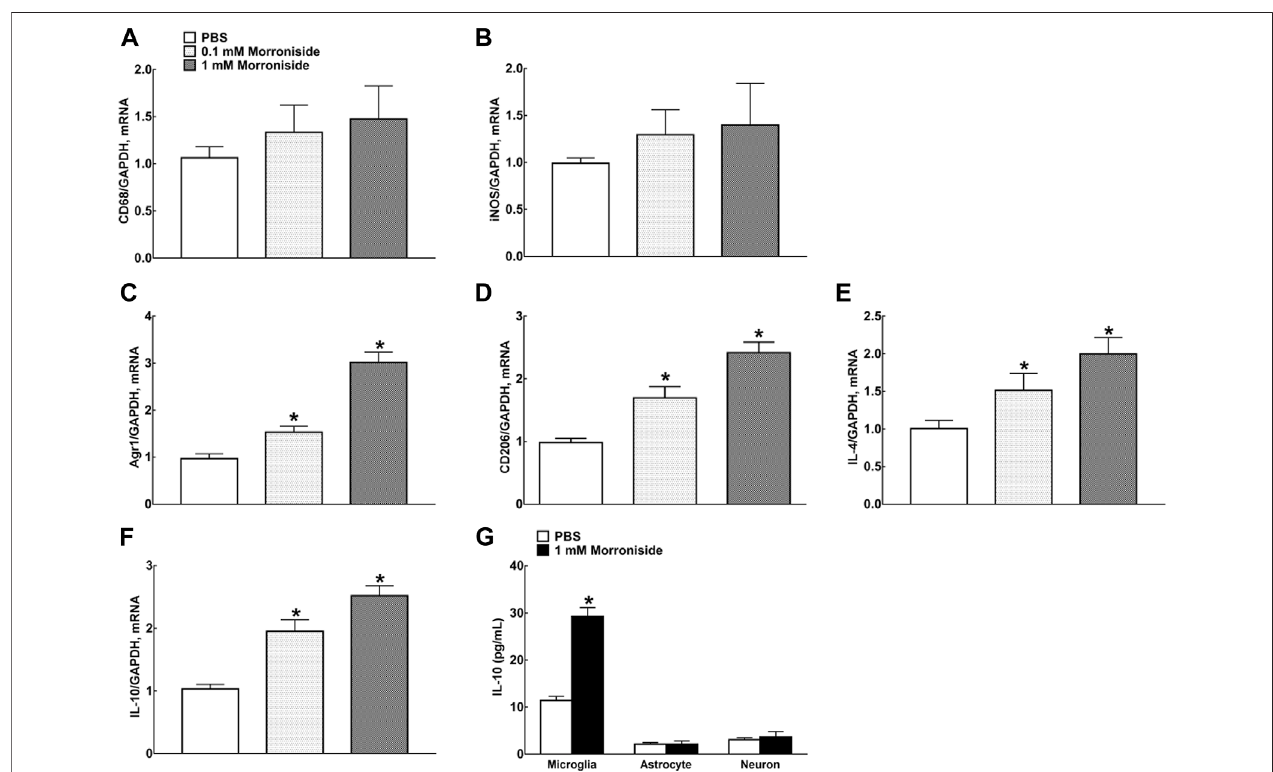
FIGURE 2 | Morroniside signi fi cantly promoted the expression of M2 polarization – related proteins in primary microglia. (A, B) Morroniside did not signi fi cantly changemRNAlevelsofmarkerproteinsCD68andiNOSforM1-typemicroglia. (C – F) Morronisidesigni fi cantlyfacilitatedmRNAlevelsofmarkerproteinsAgr1,C206,IL- 4,andIL-10forM2-typemicroglia. (G) ELISAwasexecutedtodetecttheeffectofmorronisideontheexpressionofIL-10proteinindifferenttypesofprimarycells( n (cid:2) 3). The cellular experiments wererepeatedtriply and all datawereshown asmean ± SEM. *Denoted statistical signi fi cance compared withcontrolgroup (* p < 0.05by using one-way ANOVA and post hoc Student – Newman – Keuls